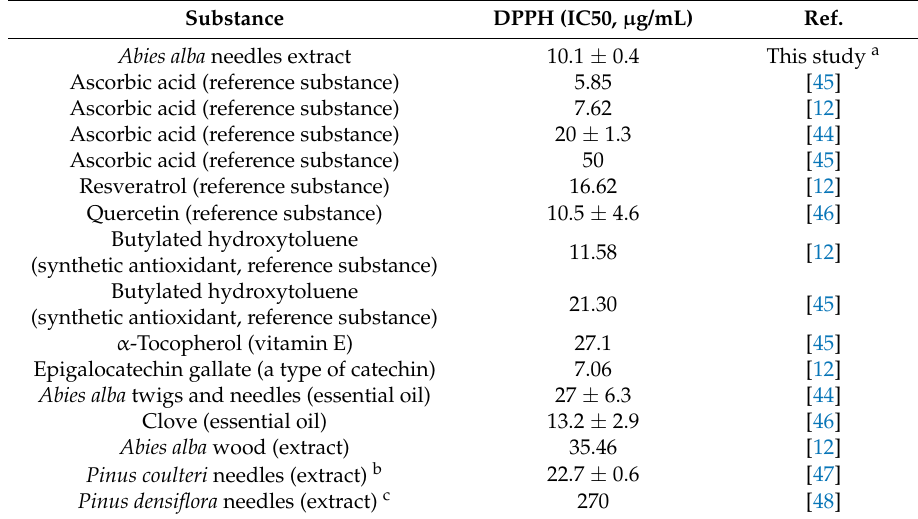
Table 4. DPPH antioxidant activity: the highest level (lowest IC50) found in this study, and levels found for other substances. Where available, the respective standard deviations are indicated.